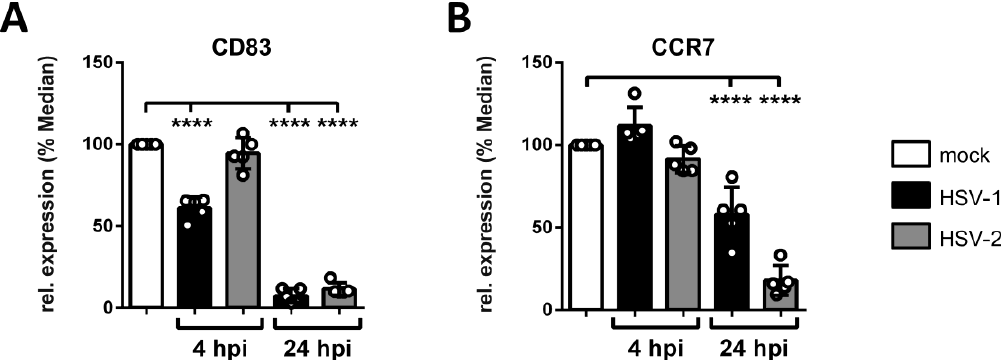
Figure 5. HSV-2 reduces the surface expression of the chemokine receptor CCR7 on mDCs 24 hpi. Mock-, HSV-1- (MOI of 2), or HSV-2-infected (MOI of 5) mDCs were harvested 4 hpi and 24 hpi. Cells were stained with antibodies specific for ( A ) CD83 or ( B ) CCR7 for flow cytometric analyses. Median values of HSV-1-(GFP-positive; black bars) and HSV-2-infected cells (gray bars) are depicted relative to mock-treated cells (white bars; set to 100%). The experiment was performed five times with cells from di ff erent healthy donors. Error bars indicate ± SD. Significant changes (**** = p < 0.0001) are marked by asterisks.